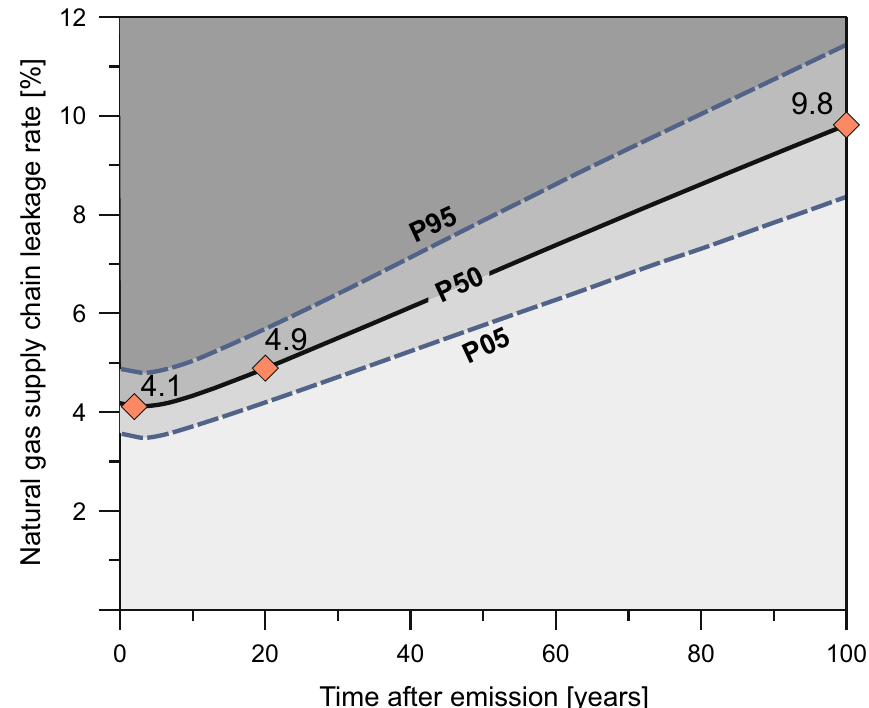
Figure 2. Coal-to-gas fleet conversion model showing the time dependent break-even leakage rates for the natural gas supply chain. Leakage rates below this limit will produce overall less GHGs by natural gas than by coal fired power plants in Germany. To visualize uncertainty, the 5 th , 50 th and 95 th percentiles (P05, P50 [median], P95) were calculated for each time step. The medians for GWP 20 , GWP 100 and an immediate GWP are